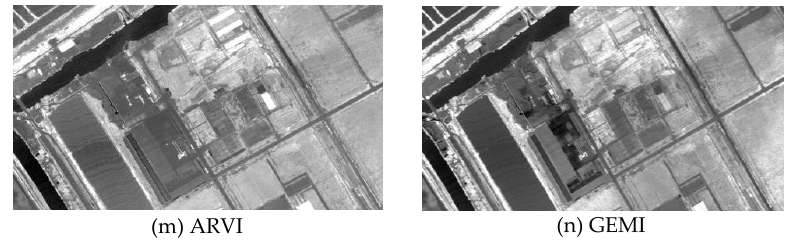
Figure 4. Blue, green, red and near infrared bands and vegetation indexes derived from hyperspectral images (( a ): blue band; ( b ): green band; ( c ): red band; ( d ): NIR; ( e ): RVI; ( f ): NDVI; ( g ): GNDVI; ( h ): DVI; ( i ): RDVI; ( j ): EVI; ( k ): TVI; ( l ): VARI; ( m ): ARVI; ( n ): GEMI).